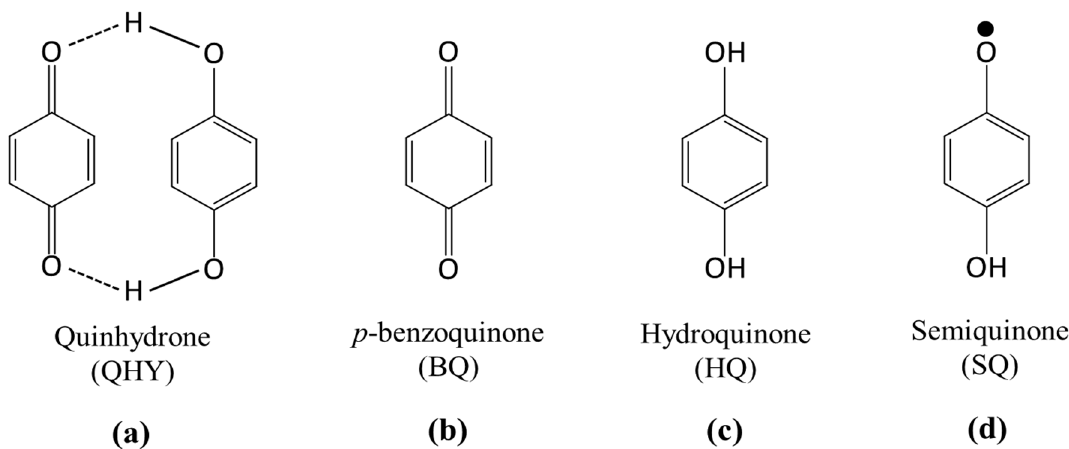
Figure 1. Molecular structures of ( a ) quinhydrone (QHY); ( b ) p-benzoquinone (BQ); ( c ) hydroquinone (HQ); ( d ) semiquinone (SQ).